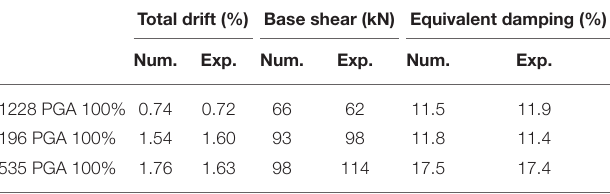
TABLE 2B | Experimental and numerical results at PGA 100%. Total drift (%) Base shear (kN) Equivalent damping (%) Num. Exp.